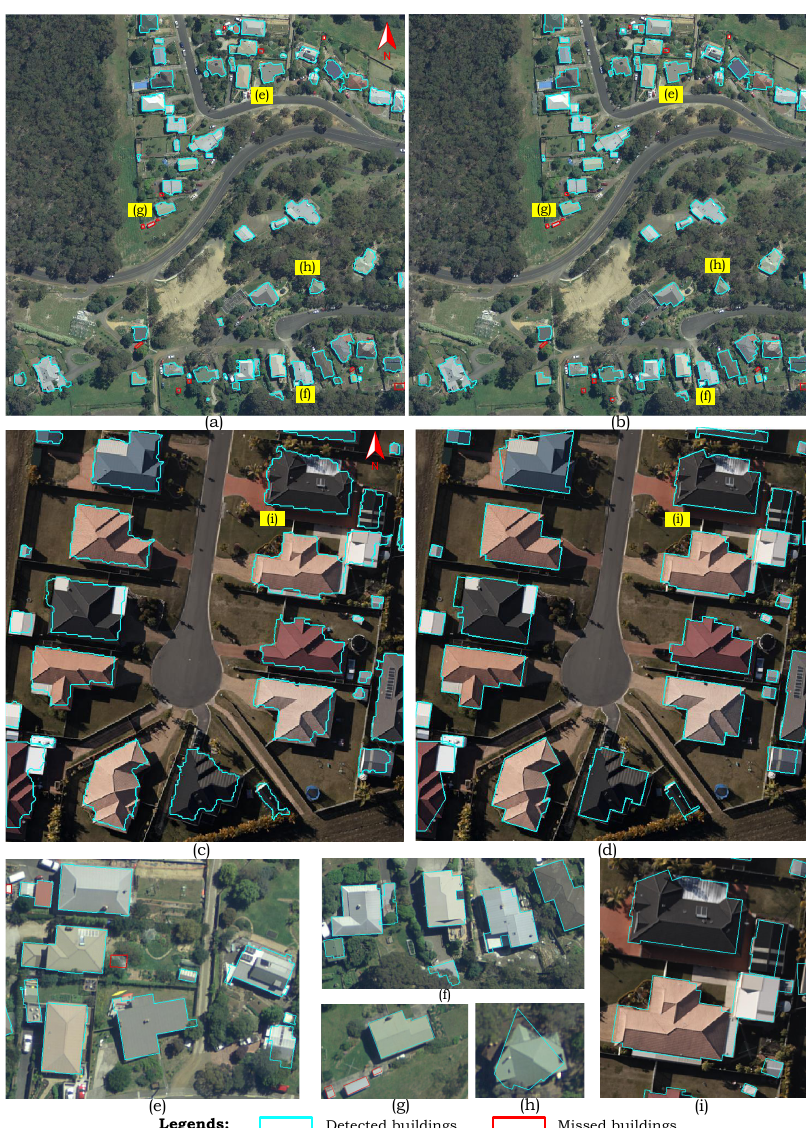
Figure 15. Building detection and regularisation on Hobart ( a , b ) and Hervey Bay ( c , d ). Building detection examples after regularisation in: ( e – h ) HT data set (1.6 points/m 2 ) ; and ( i ) HB data set (12 points/m 2 ). Areas marked in (b) and (d) are magnified in (e) to